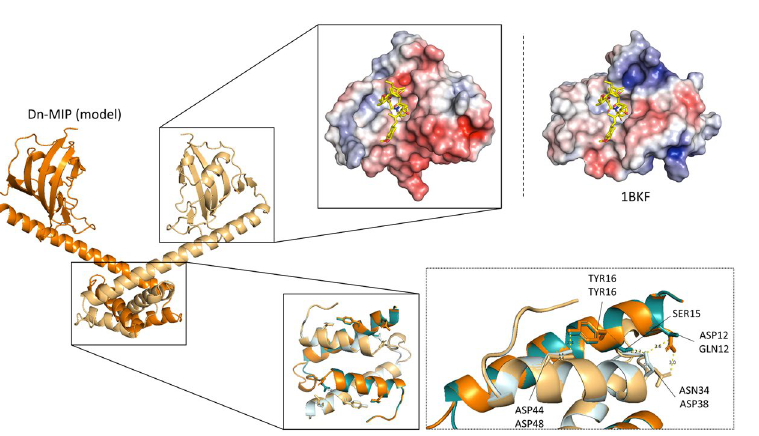
Figure 2. Homology model of Dn-MIP based on the structure of Legionella pneumophila Mip (PDB:1FD9). The dimerization domain is shown in the zoom, forming around a hydrophobic core. The dimerisation structure of Legionella template (PDB:1FD9, shown in turquoise and light blue) and D. nodosus model (shown in gold and orange) are similar overall structure with conserved secondary structure but some changes in the loops connecting secondary structure elements. While the dimer forms around a hydrophobic core, two key polar interactions stabilising the dimer are highlighted. A second zoom shows the catalytic domain in surface presentation with the electric potential mapped onto the surface (blue, positive; red, negative). The position of the inhibitor FK506, taken from the human FKBP protein (PDB:1BKF), indicates presence of the binding pocket in